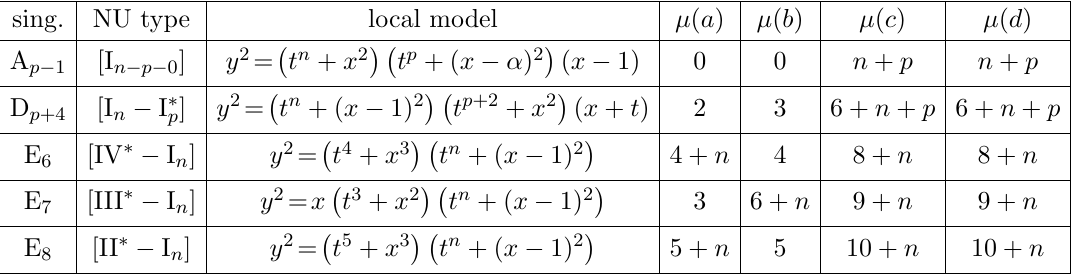
Table 2. Genus-two models for ADE